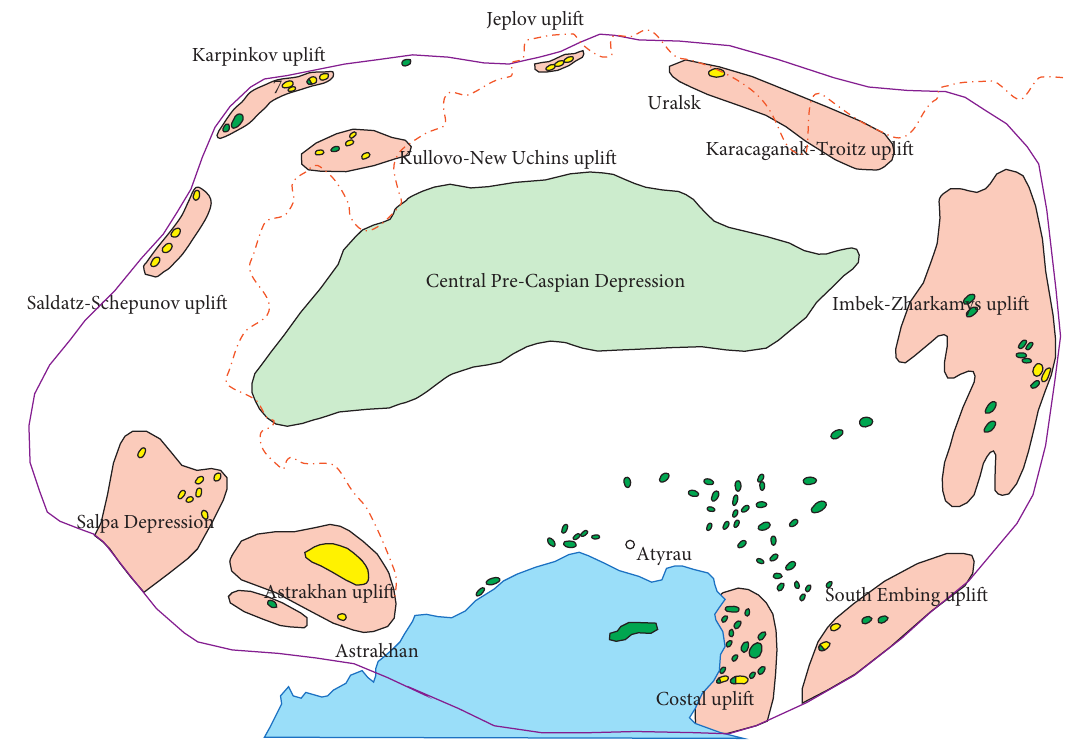
Figure 1: Structures of the Pre-Caspian Basin. Table 1: Fracture dip angle and fracture types.